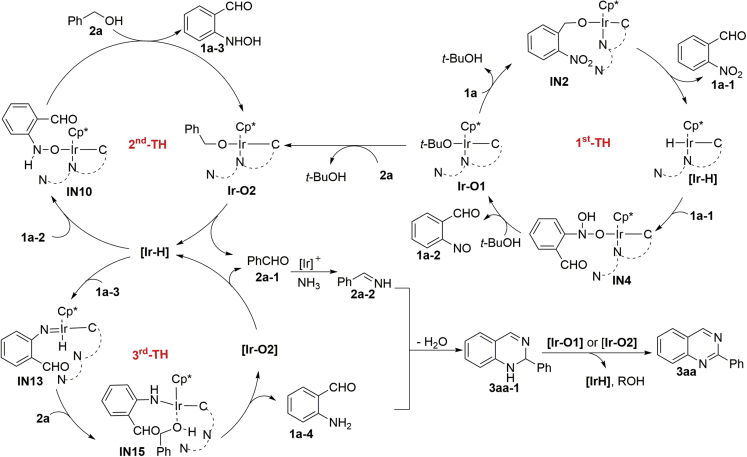
Plausible Reaction PathwayAlso see Data S1 and S2 and Figure S98.